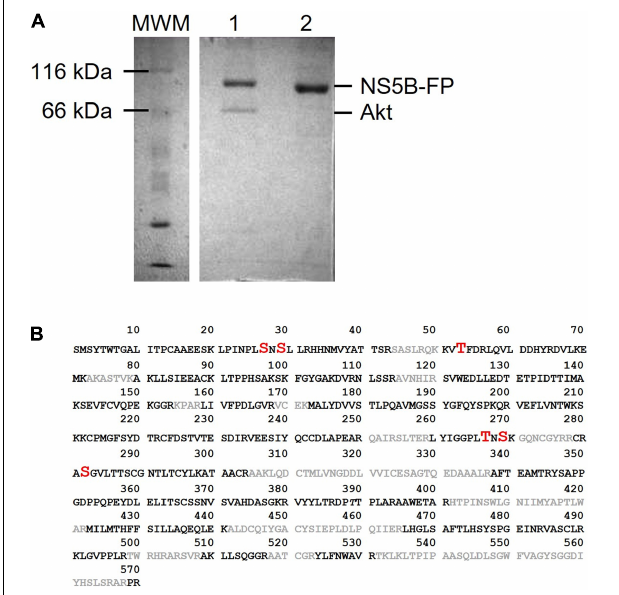
FIGURE 1 | (A) SDS-PAGE gel showing products obtained after Akt phosphorylation of NS5B-FP (lane 1). Unphosphorylated NS5B-FP is shown in lane 2. Molecular weight marker (MWM) is on the left of the gel and sizes for NS5B-FP and Akt are indicated on the right. (B) Amino acid sequence of HCV NS5B from strain HC-J4. Phosphorylated sites identified in phosphoproteomics are in red (with increased font size). Sequence uncovered by the phosphoproteomic analysis is in gray